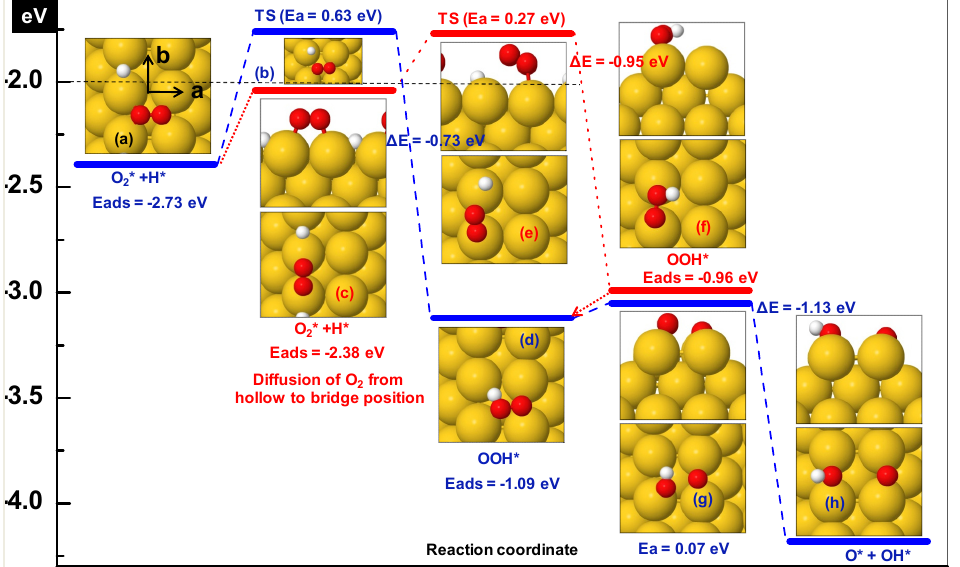
Figure 4. Potential energy diagram for hydroperoxy formation and decomposition on diatomic rows on the Au (100) surface. The horizontal dashed line shows the desorption . Zero energy corresponds to gas phase O level of O 2